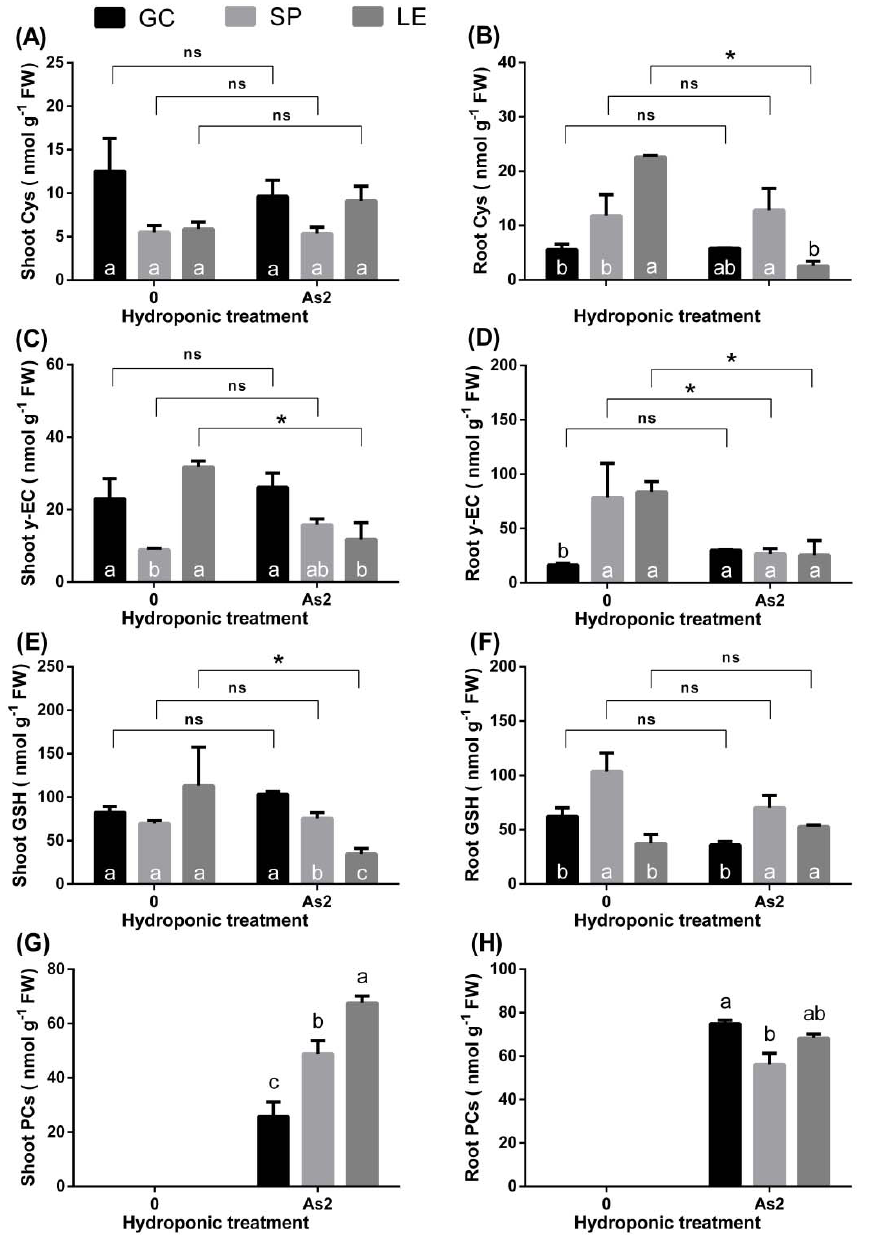
Figure 7. Content of thiol [cys ( A , B ), γ -EC ( C , D ), GSH ( E , F ), PCs ( G , H )] in the shoots and roots of vegetables in the hydroponic experiments. Note: Different lowercase letters in the figure indicate comparisons between different vegetables under the same treatment (5% levels). The symbol * indicates that the difference between values is significant at the respective 5%. The error bars in the graph indicate the SEM (standard error of the mean).